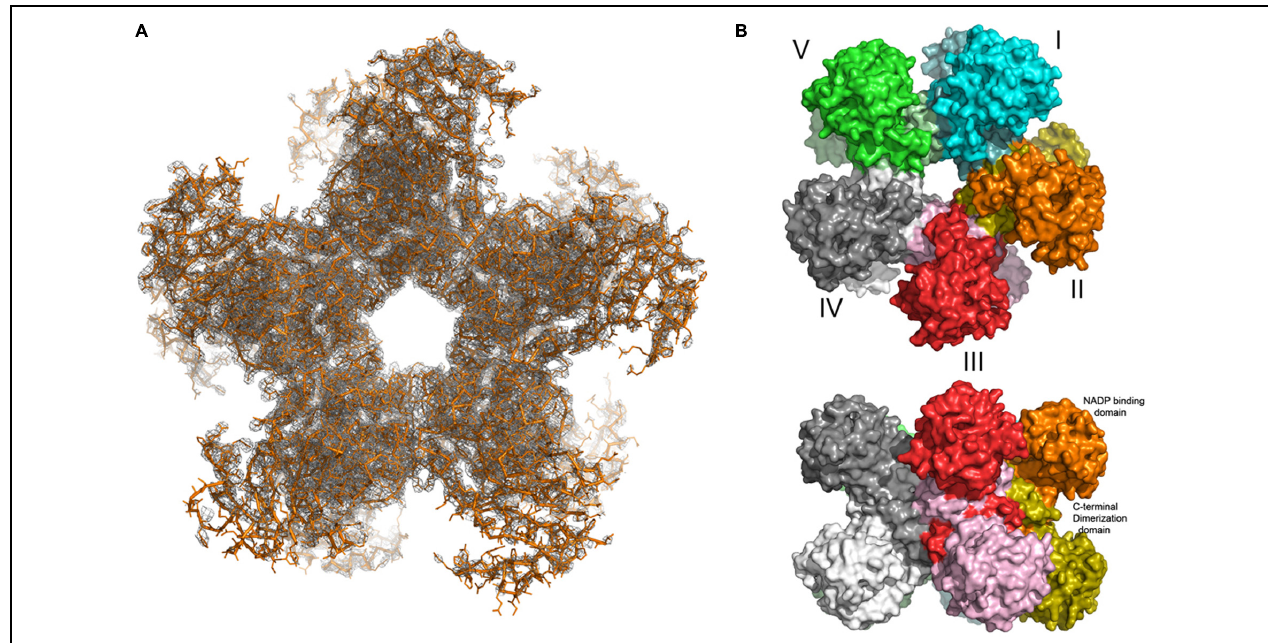
FIGURE 6 | The decameric structure of of rice P5C reductase. The top view (A) along the fivefold NCS axis reveals a pentamer of dimers, shown in orange. The two F obs – F calc density maps contour at 1 σ level covering the entire decamer is shown in gray. Top and side views (B) of the decamer in surface-representation. The subunits are shown in different colors.